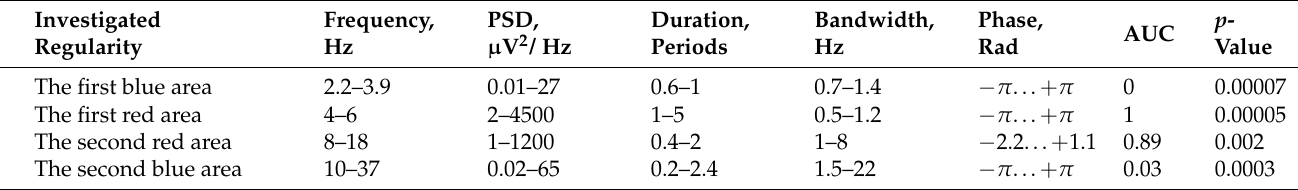
Table 1. Characteristics of cross-wave trains that distinguish PD and ET patients with left arm hyperkinetic movements.